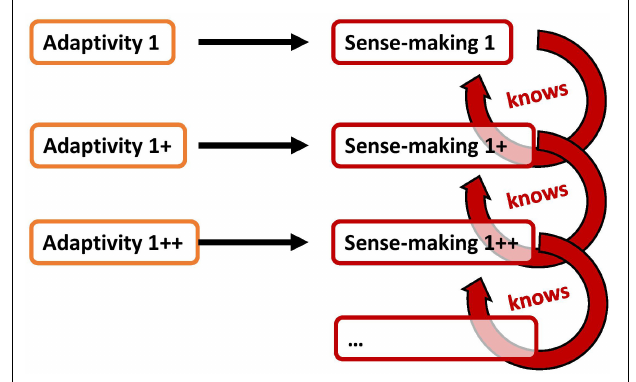
FIGURE 5 | The “sense-making-of-sense-making” approach leads to an increase of sense-making and adaptivity